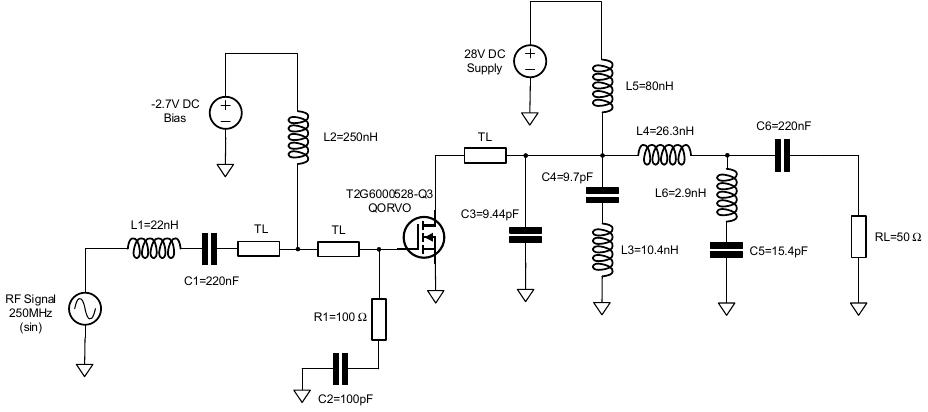
Figure 21. Practical transmission system with a 50 Ω load as an antenna.